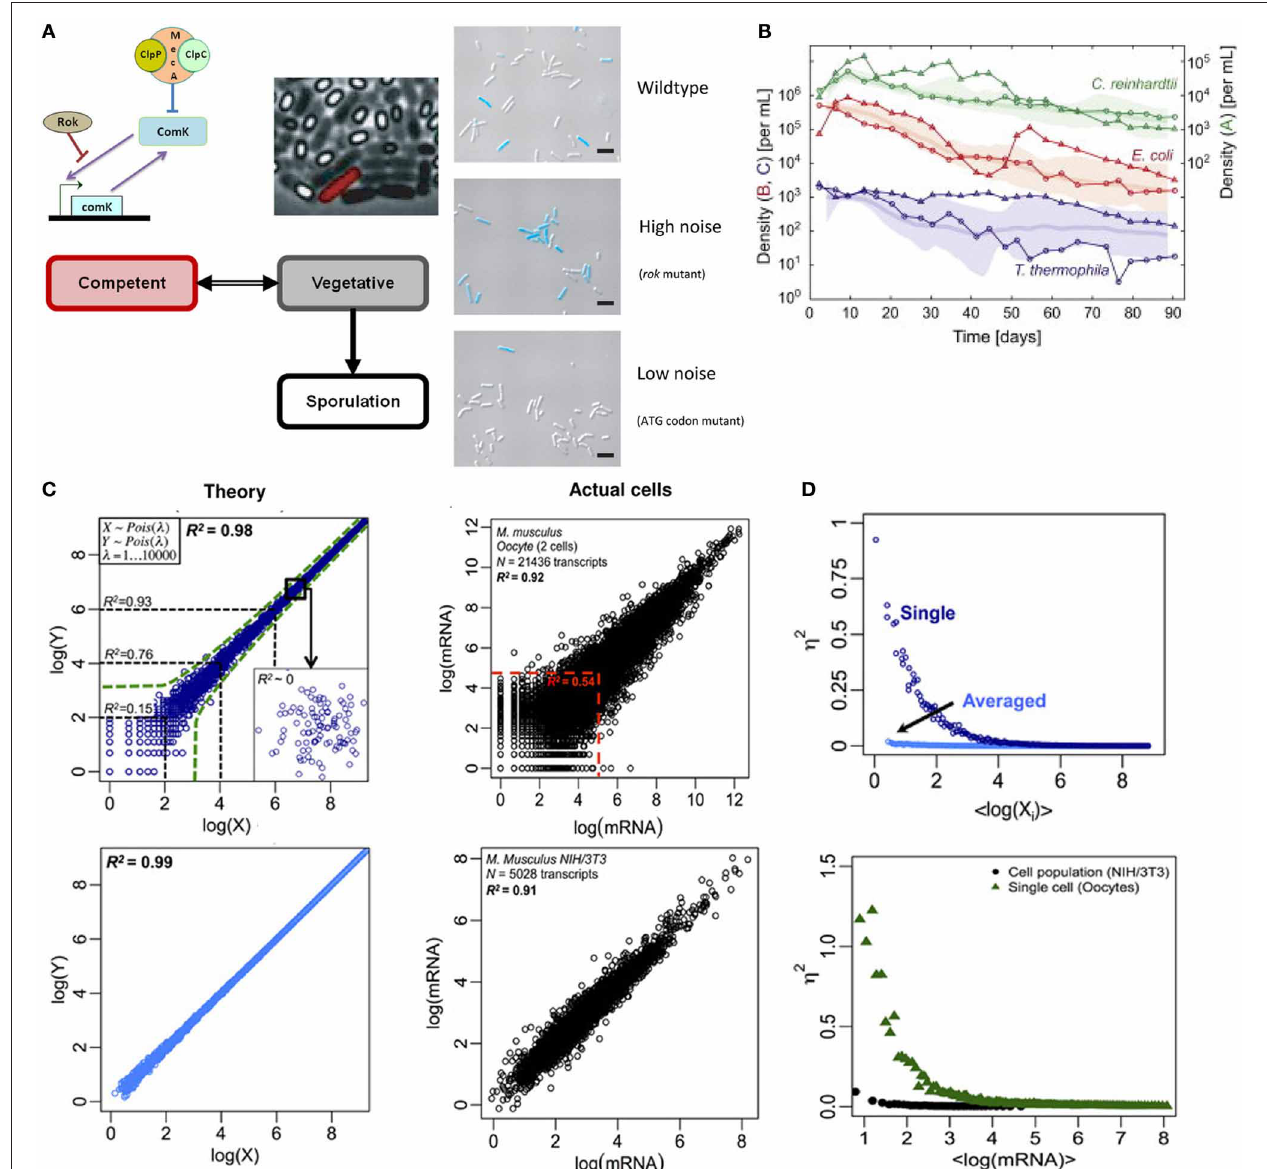
FIGURE 1 | Noisysinglecellanddeterministicpopulationlevelresponses. (A) Left:switching betweenvegetative (gray) andcompetent(red)state in B. subtilis is guidedbythe levelof stochasticnoise in the transcription of comK mRNA.Right:liveimagewherecompetentcell(blue)proportionincreaseswith stochastic noise. Notethat rok mutant exhibitsan increasedtranscriptional bursting in comK mRNAcomparedto WT strain, and themutant in ATG initiation codonreducesits translational efficiency. Figuremodifiedfrom Süel etal. (2006)andMaamaretal. (2007). (B) Populationdynamicsof C. reinhardtii , E. coli, and T. thermophila kept underconstant light and temperaturedisplay randomwalk overboundedaverage response.Figureadapted from Hekstra